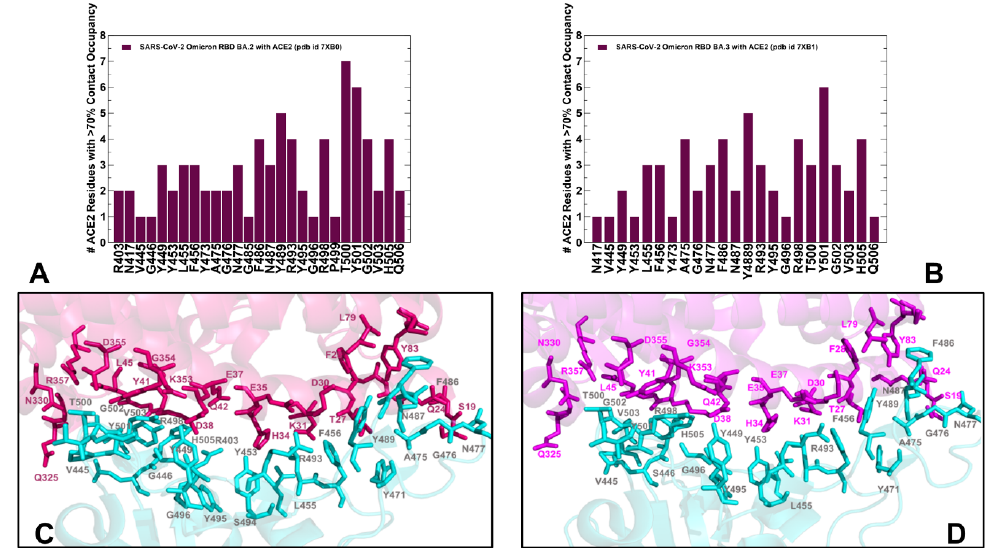
Figure 4. The distributions of the intermolecular contacts obtained by averaging results from 10 independent MD simulations of the Omicron RBD BA.2 and BA.3 complexes with hACE2. The ensemble-average number of distinct hACE2 residues making stable intermolecular contacts (>70% occupancy) with the RBD residues obtained from MD simulations of the RBD BA.2-hACE2 complex, pdb id 7XB0 ( A ) and the RBD BA.3-hACE2 complex, pdb id 7XB1 ( B ). ( C ) Structural mapping of the intermolecular RBD BA.1-hACE2 interface. The RBD binding residues are shown in cyan sticks and the hACE2 binding residues are in dark, pink-colored sticks. ( D ) Structural mapping of the intermolecular RBD BA.1.1-hACE2 interface. The RBD binding residues are shown in cyan sticks and the hACE2 binding residues are in magenta-colored sticks. The intermolecular binding interface residues are annotated.